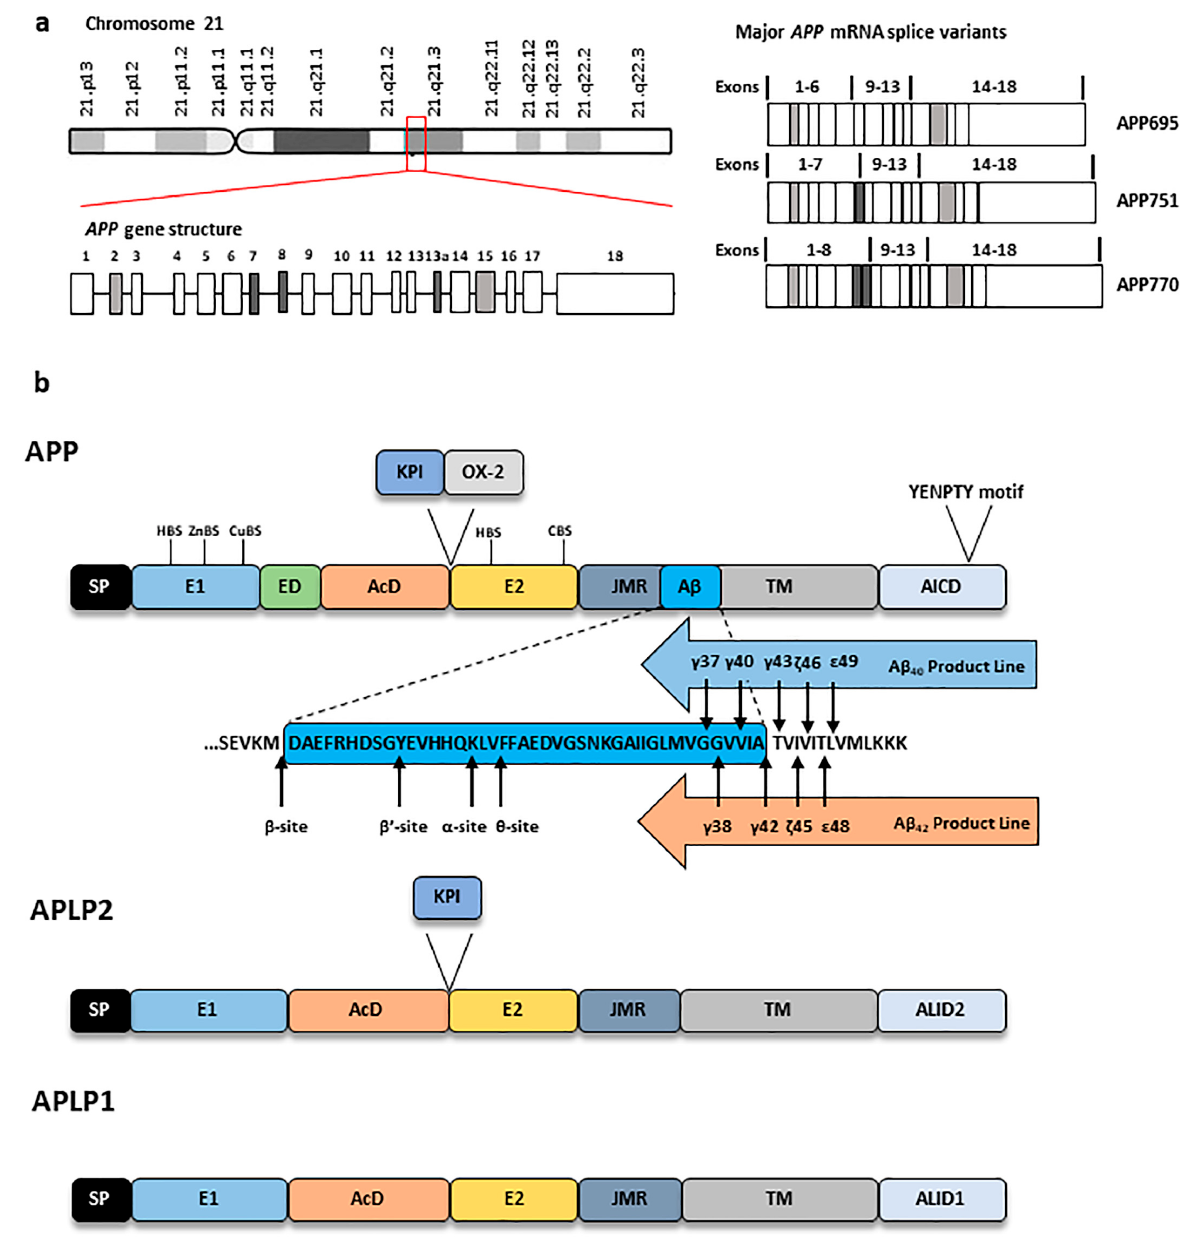
Figure 1. APP gene, mRNA and protein structure. ( a ) Structure of APP gene and mRNA. APP gene, located on chromosome 21q21.3, features 18 exons. Alternative splicing of exons 7 and 8 ( dark grey ) leads to the expression of APP695, 751 and 770 major isoforms, while differential splicing of exons 2 and 15 ( light grey ) generates APP639 and L-APP, respectively. ( b ) Structure of the three APP protein family members APP, APLP1 and APLP2. From the N-terminus to the C-terminus, APP features the cysteine-rich E1 domain (with Heparin-Binding Site (HBS), a Zinc-Binding Site (ZnBS) and Copper-Binding Site (CuBS)), the Extension Domain (ED), the Acidic Domain (AcD), the helix-rich E2 domain (with a second HBS and a Collagen-Binding Site (CBS)), the Juxtamembrane Region (JMR), the A β sequence, the Transmembrane Domain (TM) and APP Intracellular Domain (AICD) which contains a YENPTY sorting motif. APP751 and APP770 contain the additional Kunitz Protease Inhibitor (KPI) domain and an OX-2 antigen domain. Amino-acid sequence of A β region is shown along with the different secretases cleavage sites as well as the A β product lines. Both APLP1 and APLP2 lack A β sequence and present the APLP-intracellular domain 1 (ALID1) and ALID2, respectively. APLP2 features a KPI domain similarly to some APP isoforms.